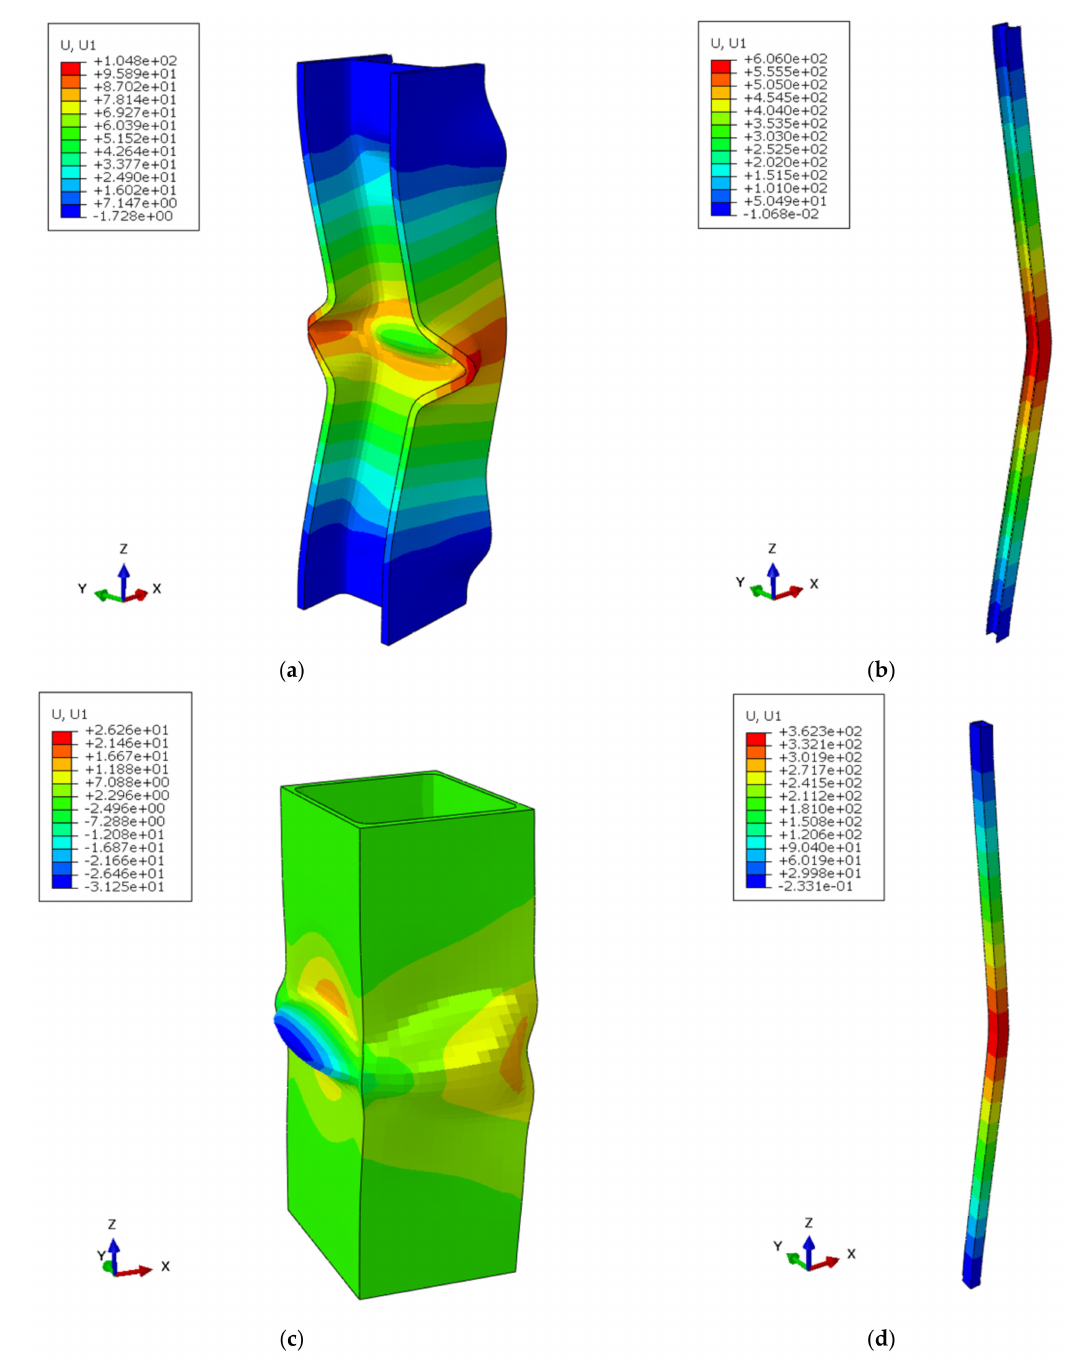
Figure 8. Displacements along X axis (mm) of buckling shapes: ( a ) HEB-200, mechanical slenderness of 9.9; ( b ) HEB-200, mechanical slenderness of 79; ( c ) two-welded UPE-200, mechanical slenderness of 4.2; ( d ) two-welded UPE-200, mechanical slenderness of